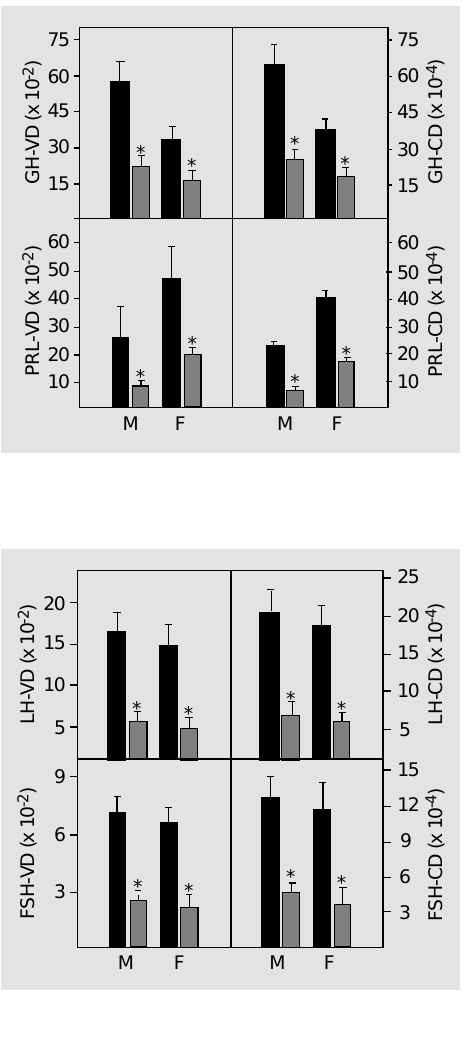
Figure 4 - Volume density (VD) and cell density (CD) of TSH and ACTH cell populations in male (M) and female (F) monkeys from the control (black bars) and undernourished (gray bars) groups. *P<0.05 compared to control (LSD test for multiple comparisons). NS, Nonsignifi-